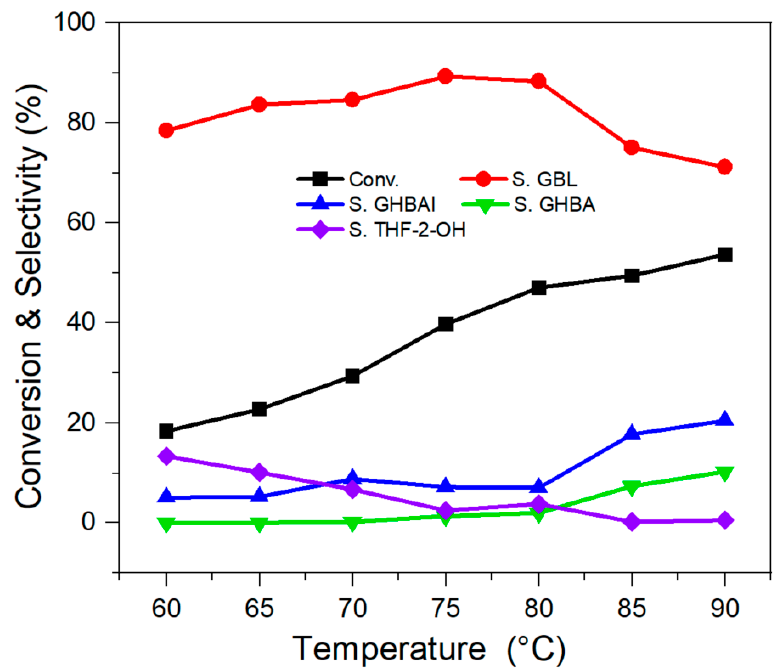
Figure 9. Conversion and selectivity for THF oxidation process at various temperatures. Reaction conditions: H 2 O 2 = 0.1 mol, THF = 0.1 mol, 0.5 g catalyst, and 9 h.